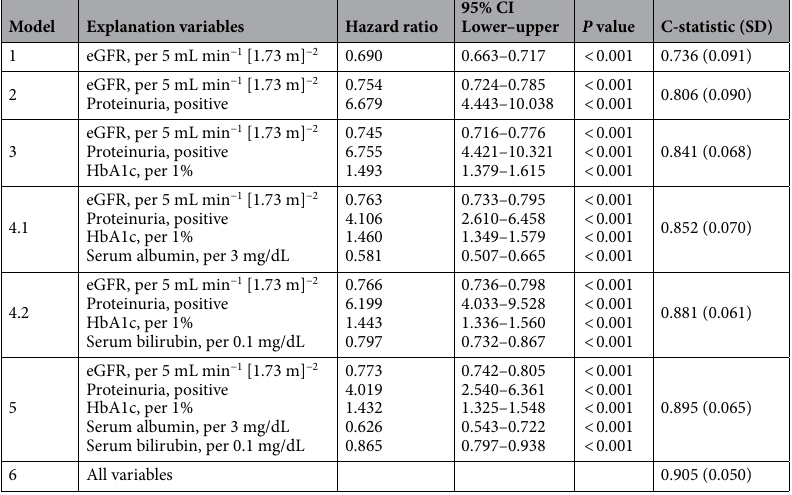
Table 3. Hazard ratios and C-statistics of various models for predicting end-stage kidney disease (ESKD) as evaluated by the Cox proportional hazard model. eGFR estimated glomerular filtration rate, HbA1c hemoglobin A1c, SD standard